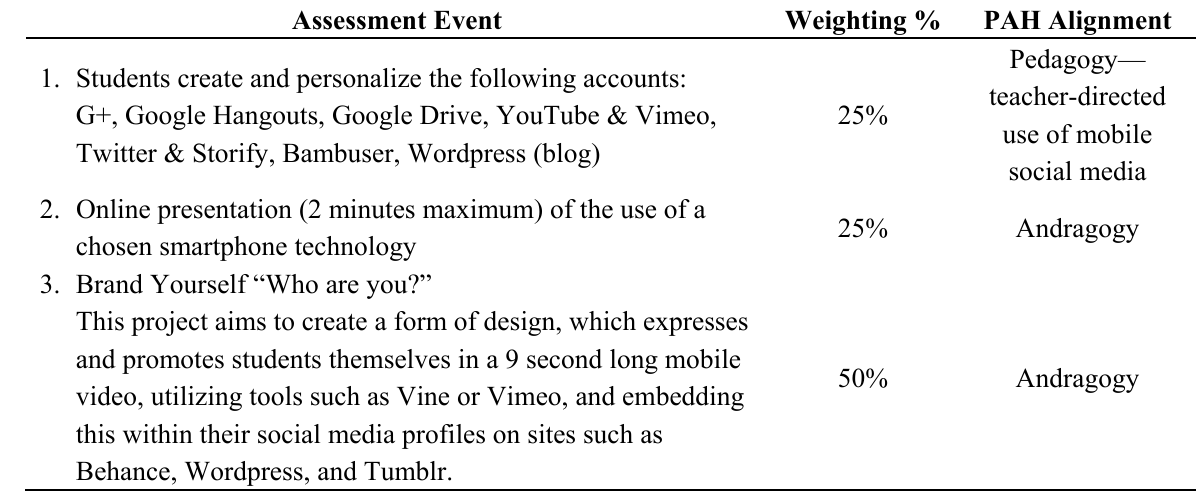
Table 5. Introduction to mobile social media assessment